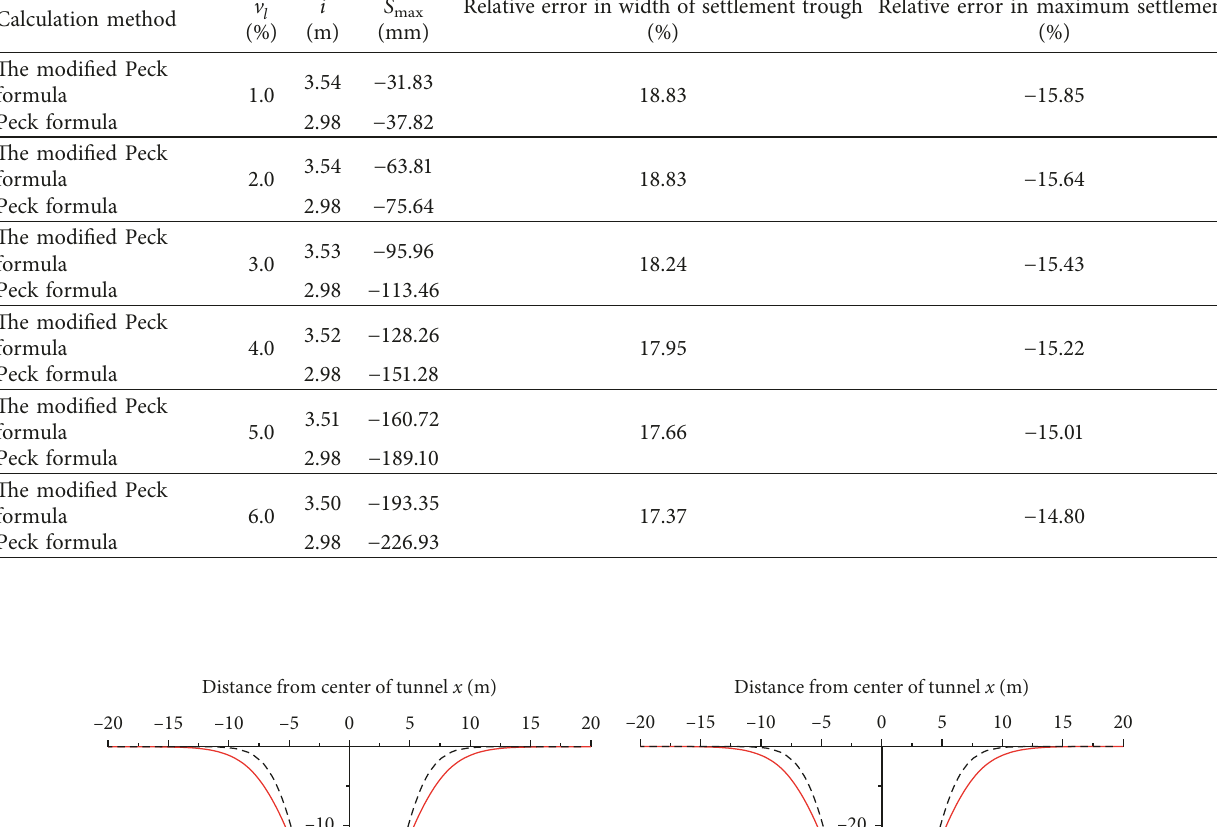
Table 5: The relevant parameters of settlement curve of each ground loss rate v